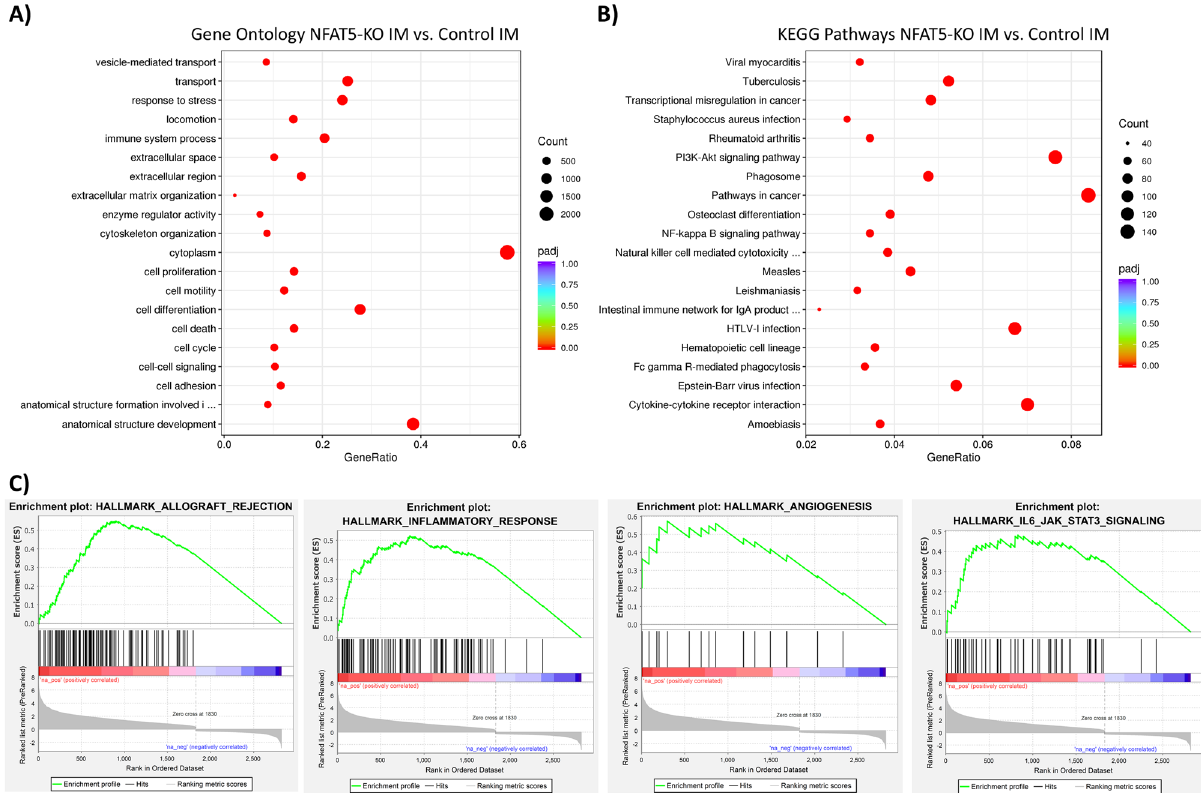
Figure 9. Enriched gene ontology terms, Enriched KEGG signaling pathways and gene set enrichment analysis of differentially expressed genes in NFAT5-KO IM vs. control IM. Differentially expressed genes in inner medulla of NFAT5-KO IM compared to control IM were used for functional annotation using gene ontology terms (GO). ( A ) The top 20 statistically enriched GO terms. ( B ) The top 20 KEGG signaling pathways associated with the differentially expressed genes. ( C ) The top 4 enriched gene sets from the differentially expressed genes using